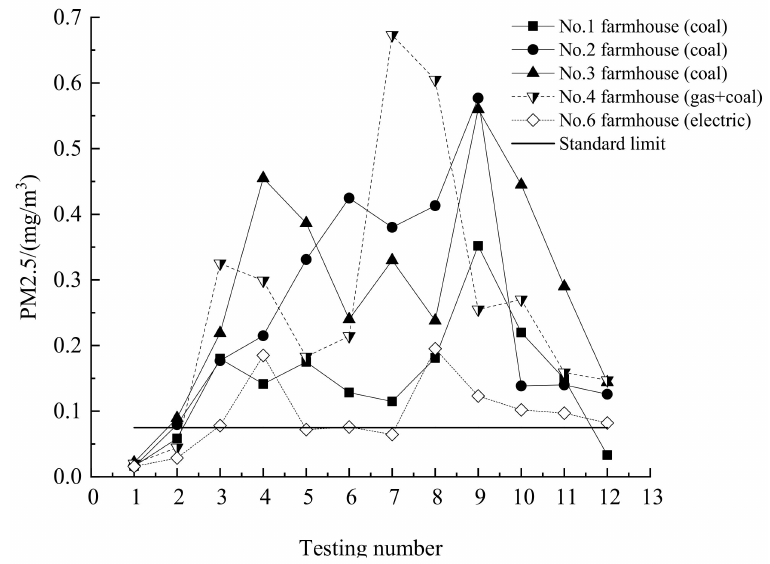
Figure 4. Changes in PM 2.5 content in various